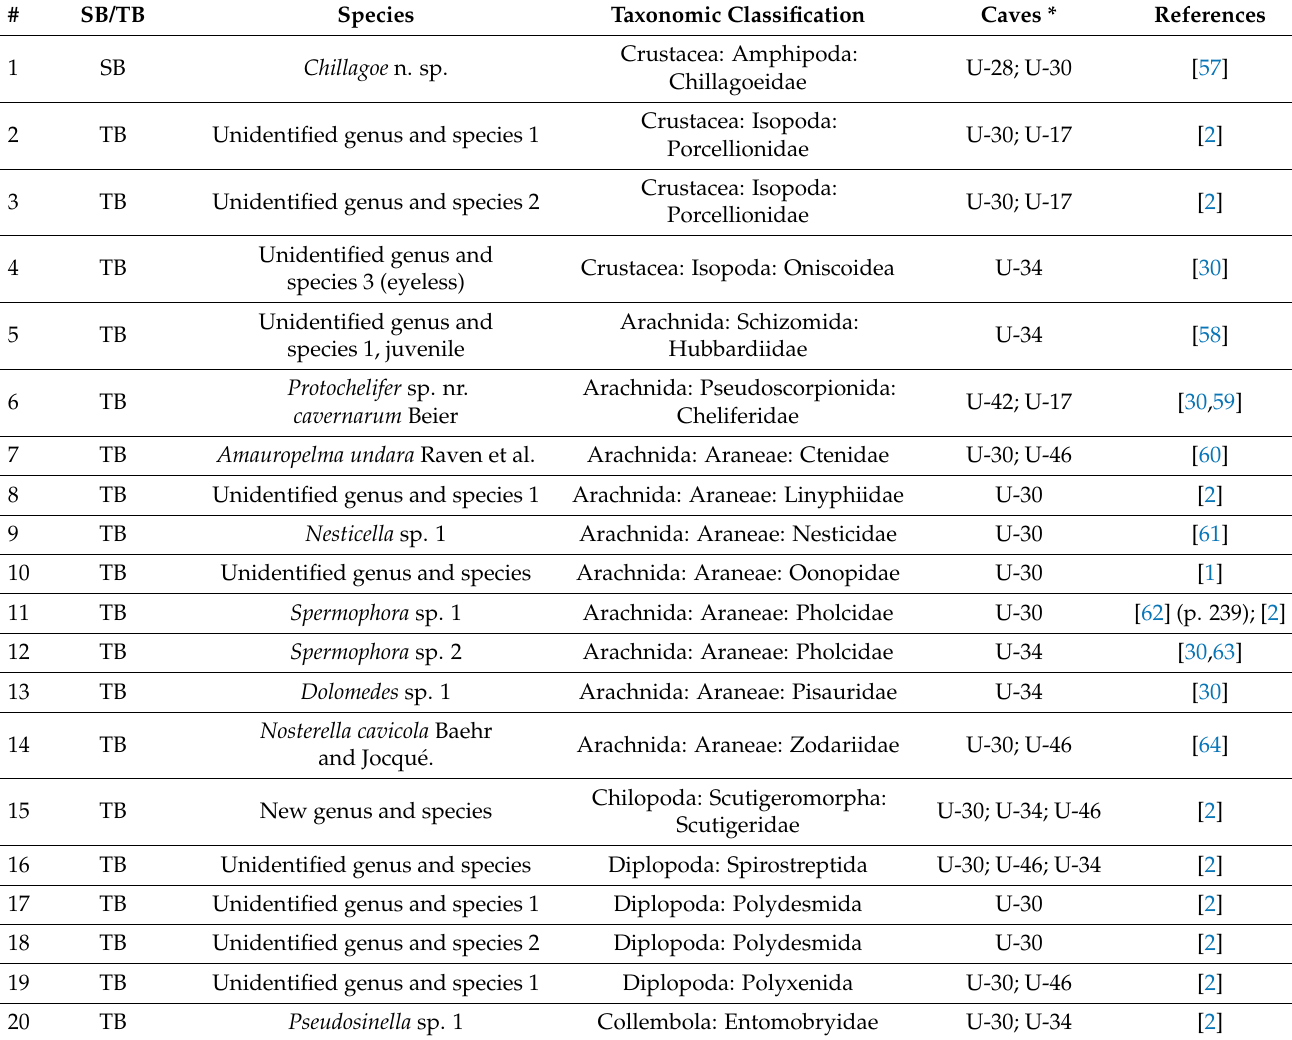
Table 3. List of obligate cave species recorded from the Undara lava tube system. Troglobionts (TB), stygobionts (SB). * Indicates cave identification number, Australian Speleological Federation (ASF). Refer to Supplementary Materials for a list of troglophiles (Table S1) and trogloxenes, accidentals (Table